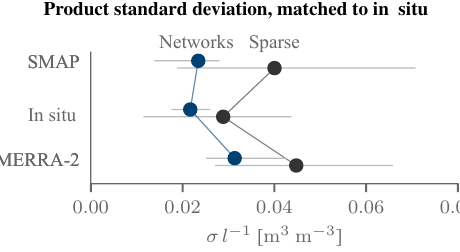
Figure 9. Estimated noise level normalized to the in situ dynamic range. For both the network and the sparse in situ sites, the distri- bution of the posterior median values of σl − 1 is summarized by the median (marker) and the interquartile range (horizontal